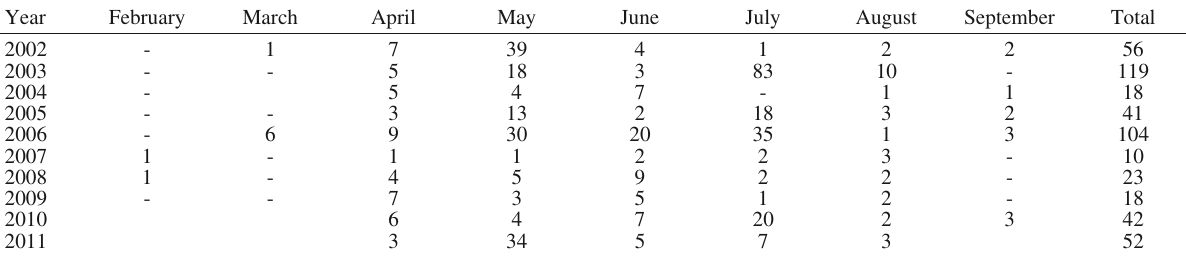
Table 3. – Monthly cetacean strandings recorded on the Romanian littoral during the past 10